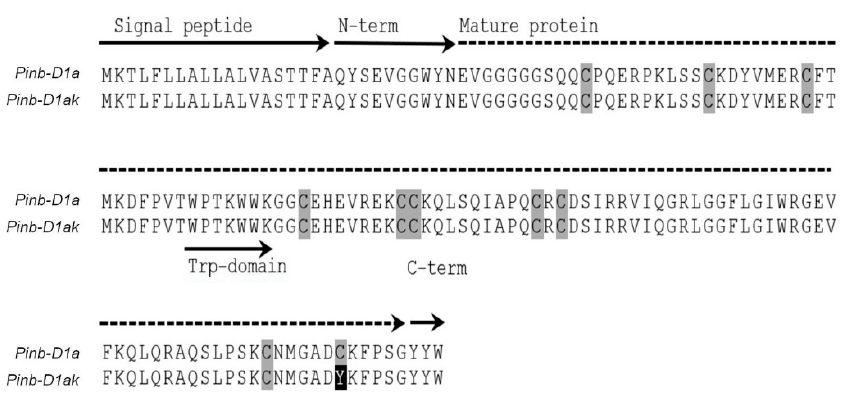
Figure 5. PINB-D1 protein structure and Trp-domain. The ten cysteine residues are marked in grey. Amino acid change C140Y for Pinb-D1ak allele is indicated in black.